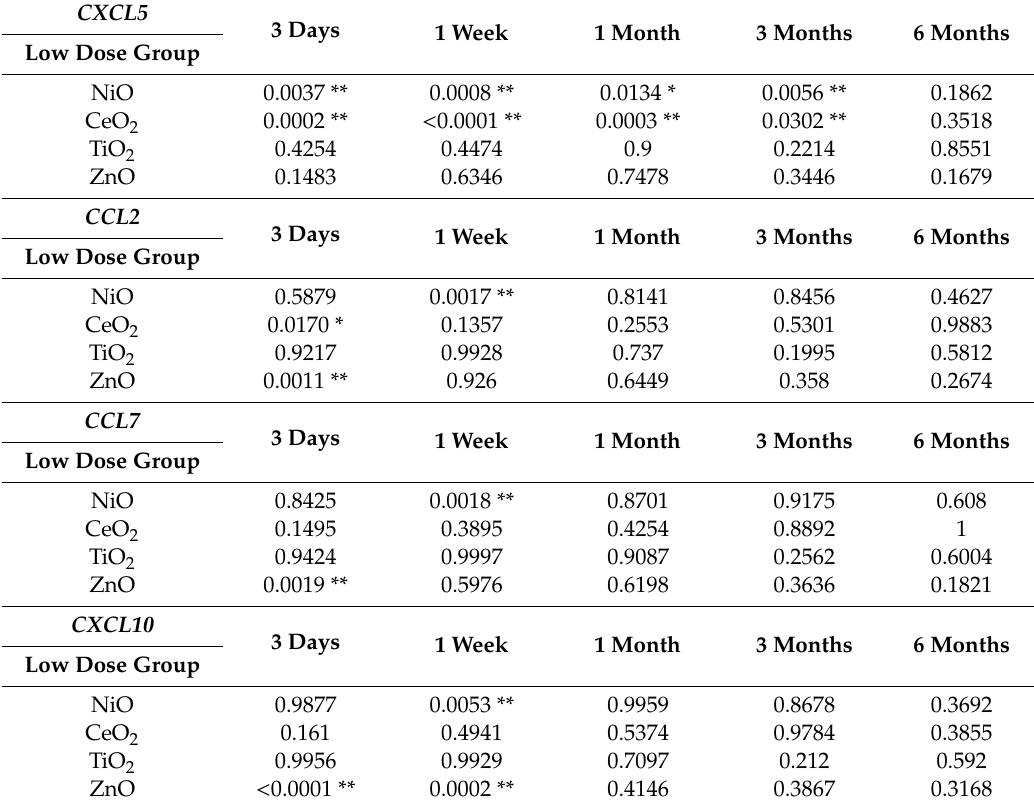
Table A2. p values of gene expression of 5 chemokines in lung exposed to nanomaterials.